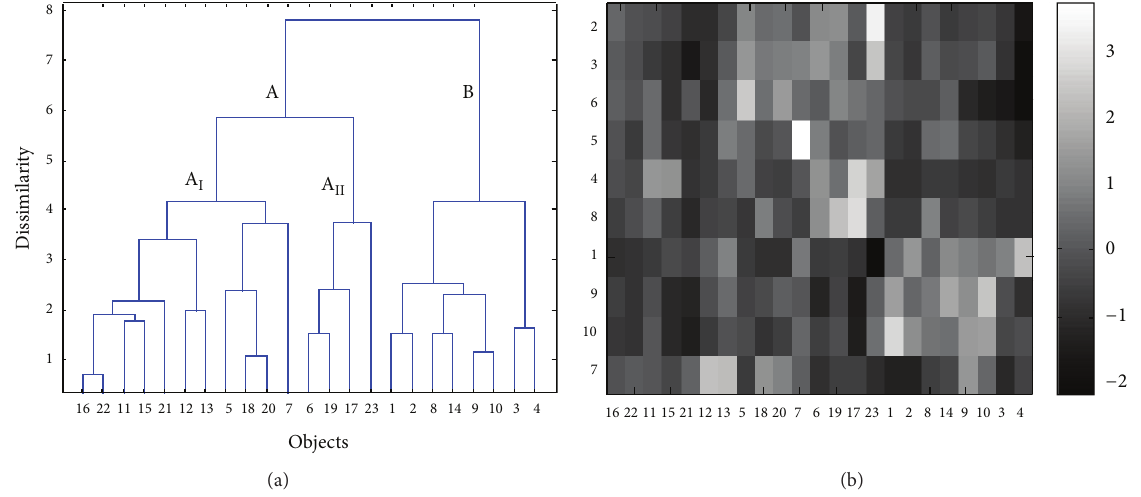
Figure 3: Dendrogram of samples with visual complement in the space of ten